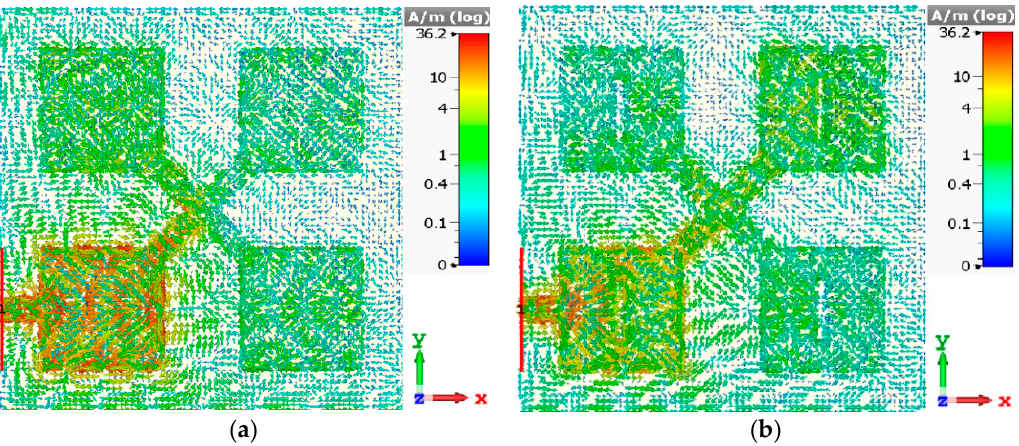
Figure 7. Surface current distributions at the spot frequency of 80 GHz, ( a ) “without” slots, and ( b ) “with” slots.